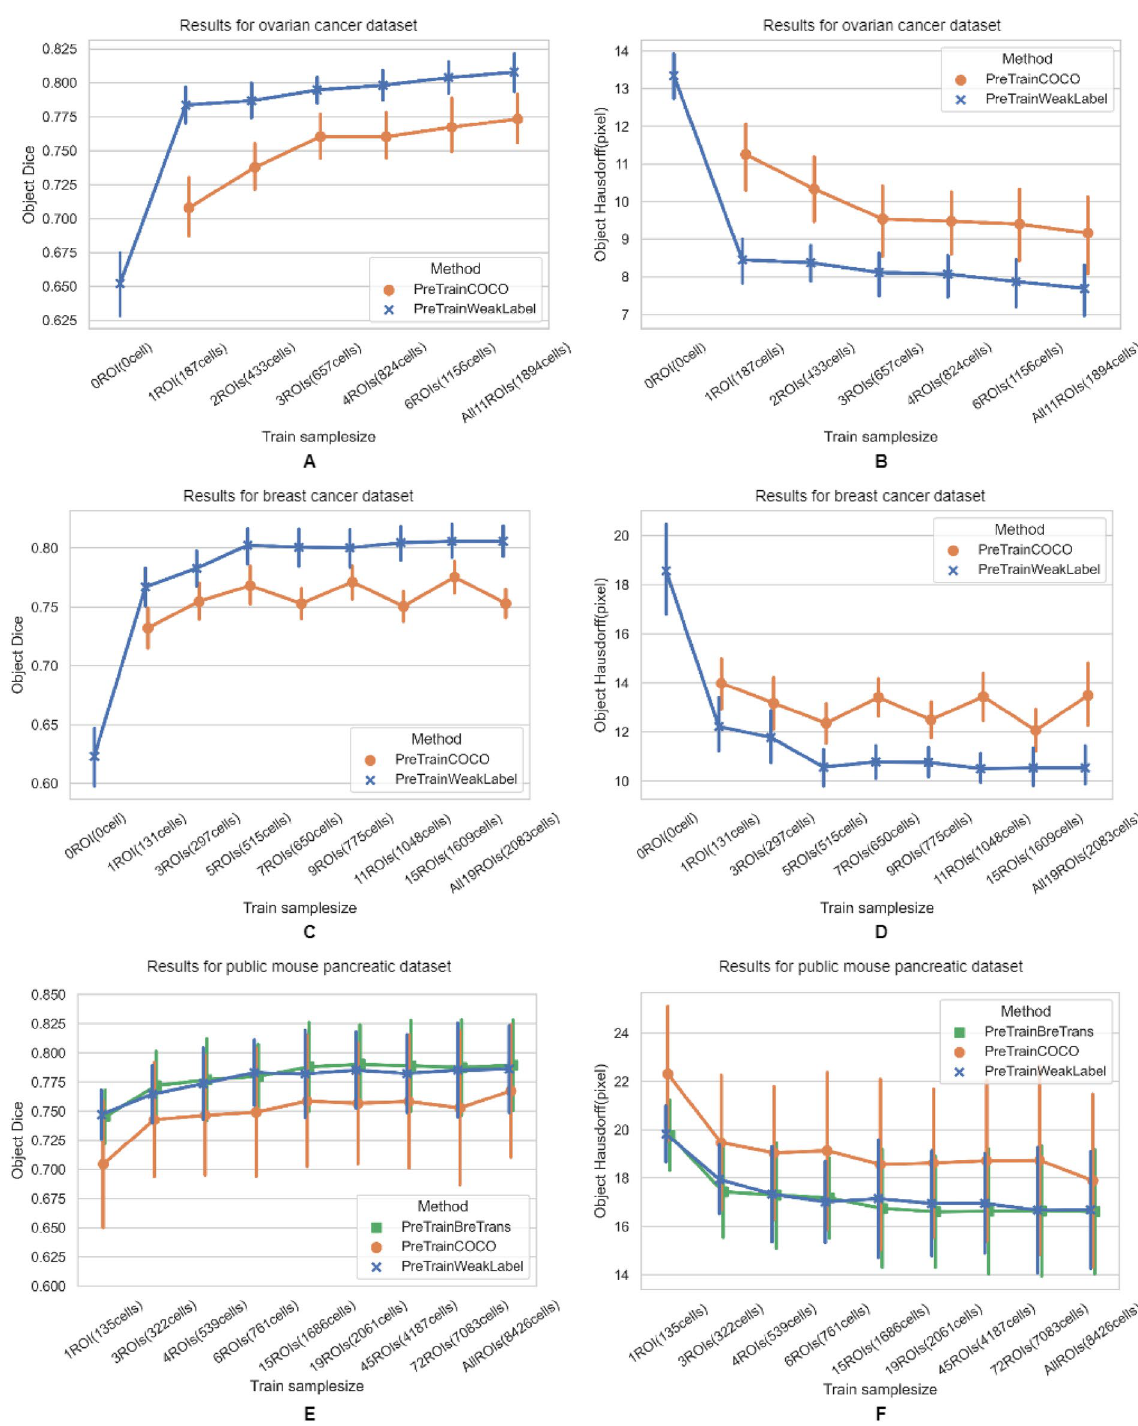
Figure 5. Experiment results on three different datasets using different training sample sizes for training. Left and right columns are OD vs. training sample size and OH vs. training sample size respectively. ( A , B ), ( C , D ), and ( E , F ) are the results using the ovarian cancer dataset, breast cancer dataset, and public mouse pancreatic dataset respectively. Color code in the plots represents different